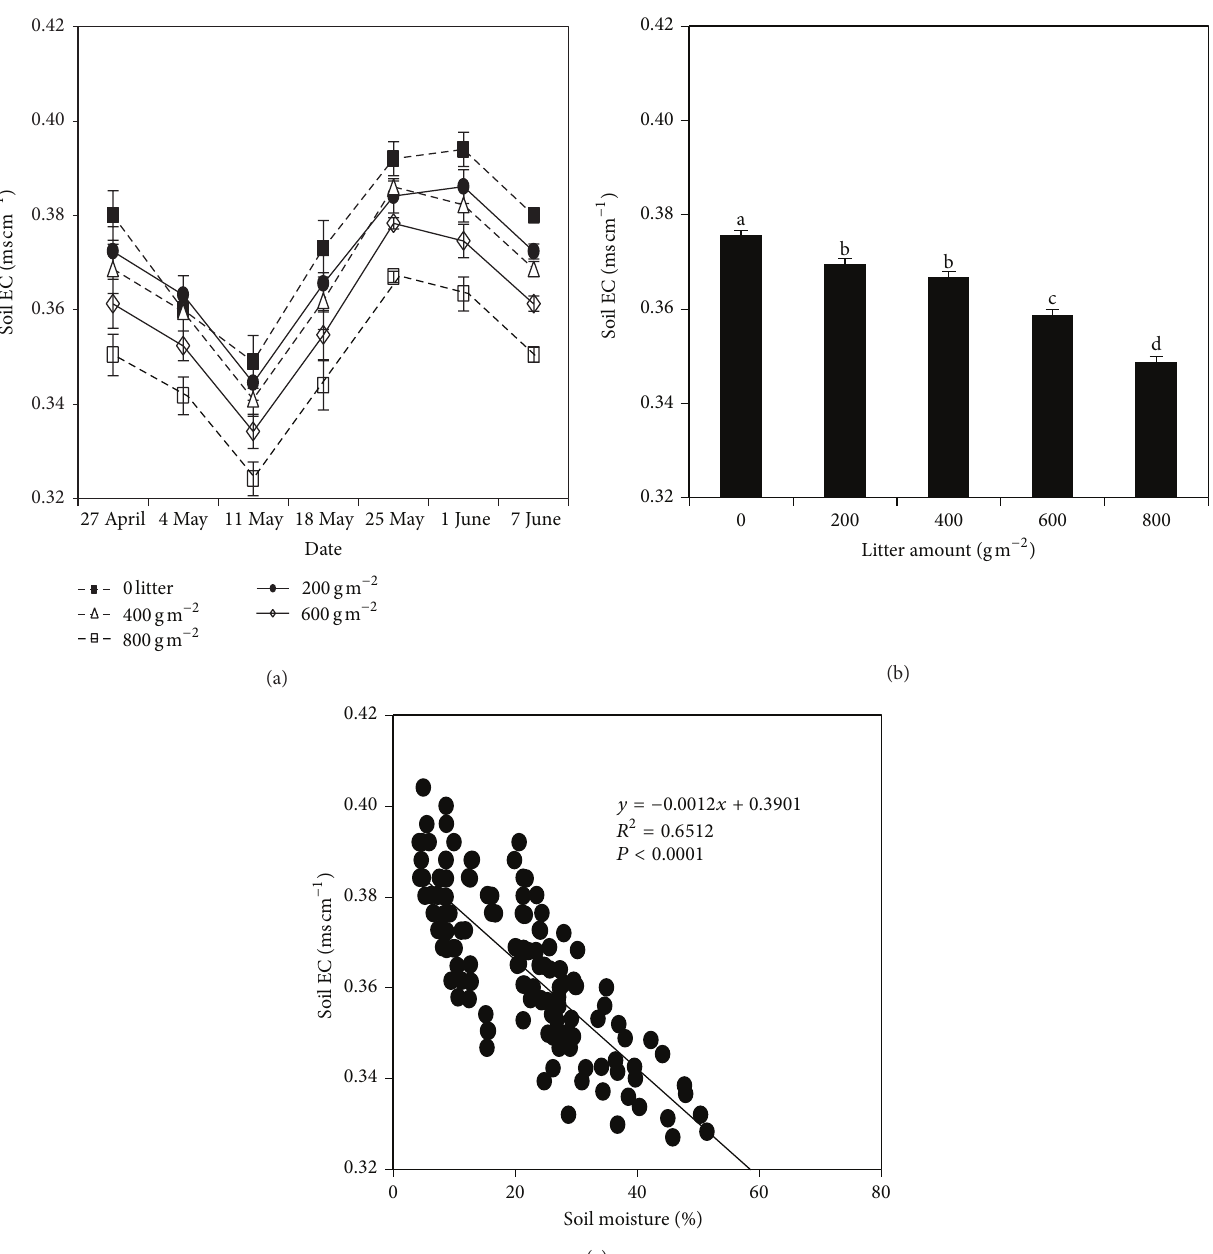
Figure 2: The temporal dynamic (a) and mean values (b) of soil electrical conductivity (EC), and the relationship between soil EC and soil moisture (c); the bars with mean ± SE represent mean soil temperature and moisture from 27 April 2011 to 7 June 2011; different letters indicate significant difference between treatments at 𝑃 < 0.05